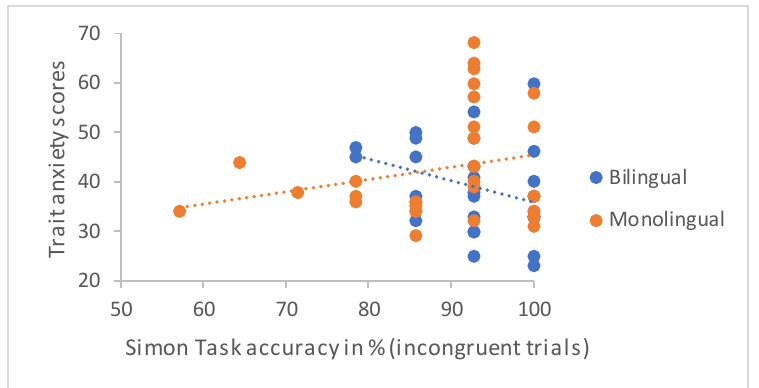
Figure 3. Effects of trait anxiety on accuracy on incongruent trials of the Simon Task in monolinguals and bilinguals.